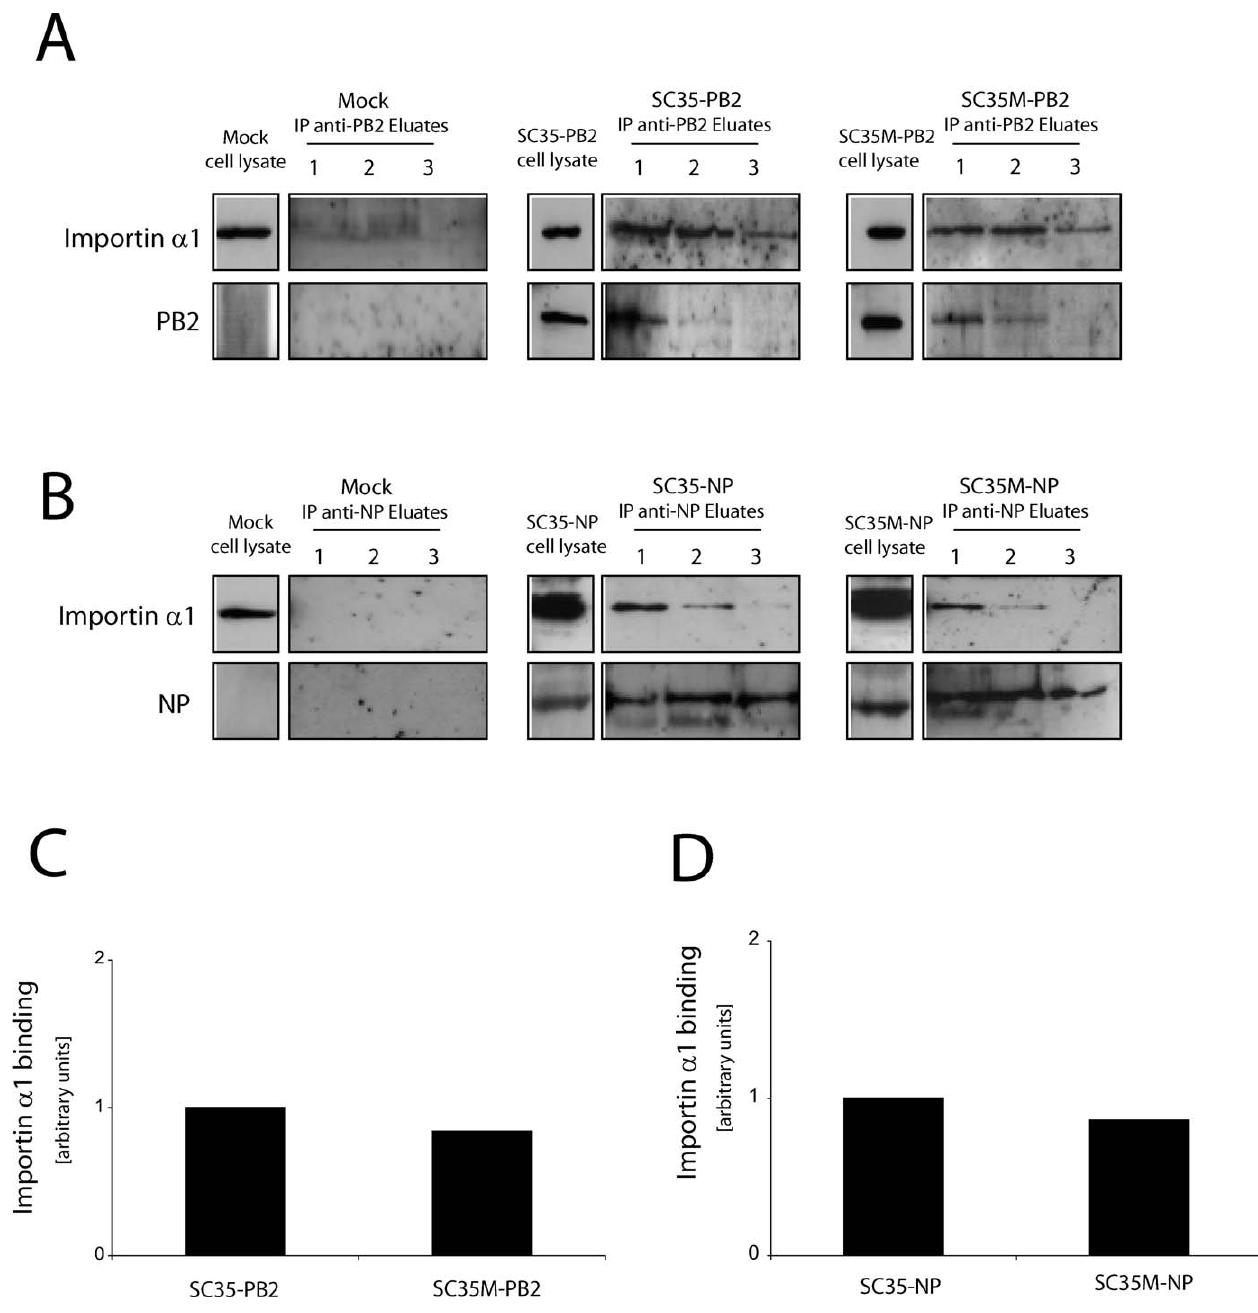
Figure 2. Interaction of PB2 and NP with Importin a 1 in Avian Cells CEC-32 cells were transfected with plasmids encoding SC35-PB2 (30 l g), SC35M-PB2 (30 l g), and SC35-PB2 D701N (30 l g) (A) and SC35-NP (10 l g) and SC35M-NP (10 l g) (B) proteins. As a control, non-transfected cells were used (Mock). 48 h after transfection cells were harvested and immunoprecipitated using the respective PB2 or NP antibody. Precipitated eluates (1–3) and non-precipitated whole cell lysates of transfected cells were subjected to SDS gel electrophoresis, and PB2, NP, and importin a 1 were detected by Western blot analysis. Importin a 1 bound to PB2 (C) and NP (D) was quantitated as described in the legend of Figure 1.